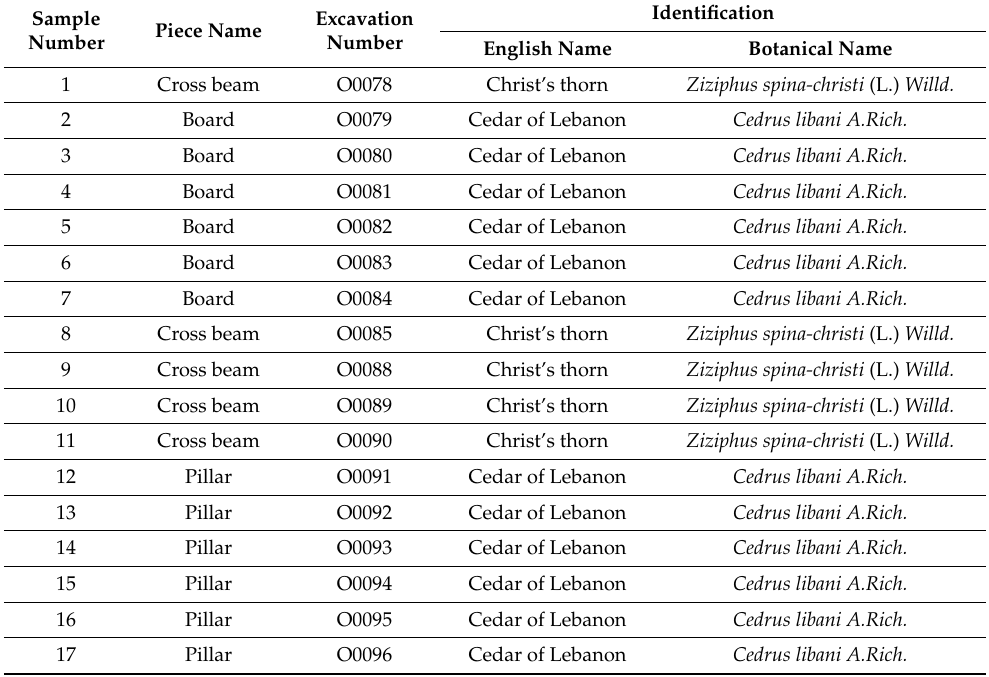
Table 3. Sample number, piece name, excavation number, and species identification for the forecas- tle